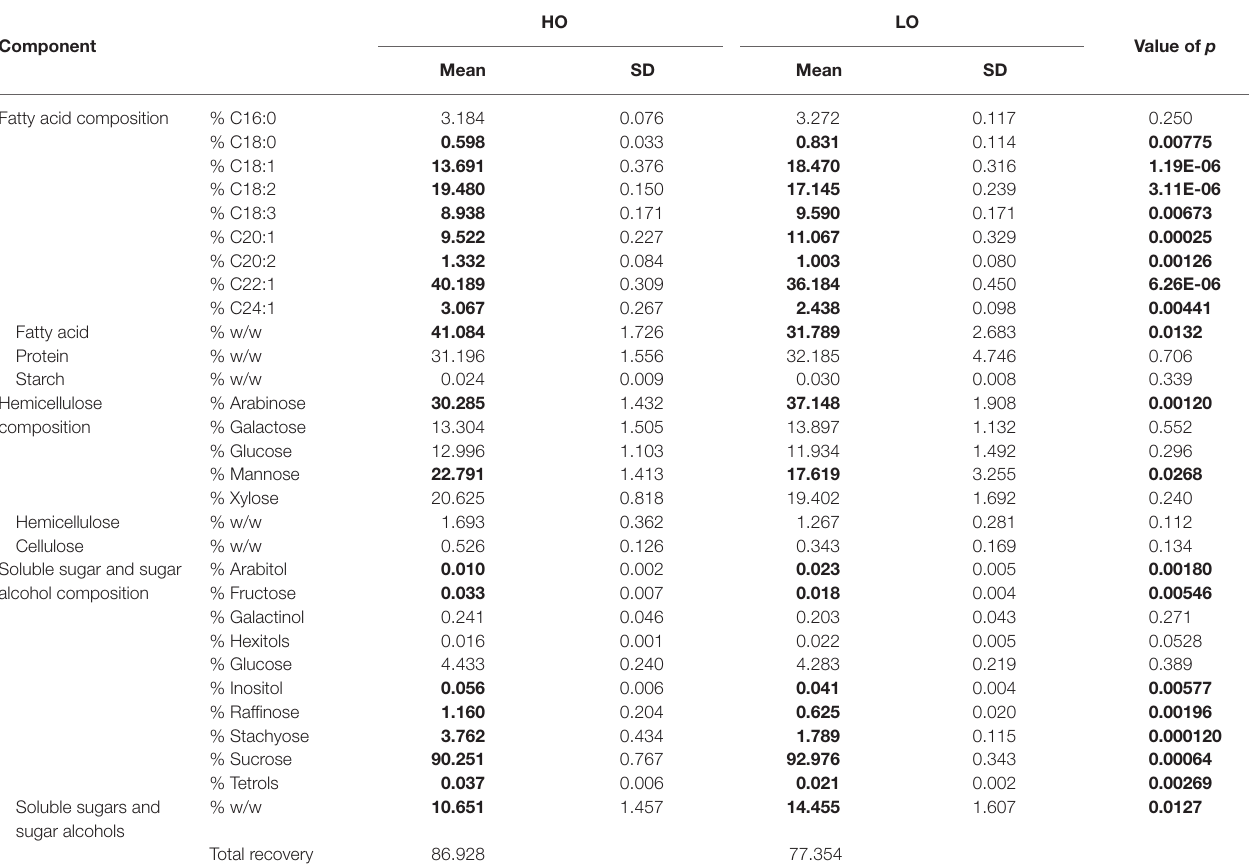
TABLE 1 | Total biomass composition (% composition and % w/w) per embryo in mature pennycress embryos of HO and LO accessions.